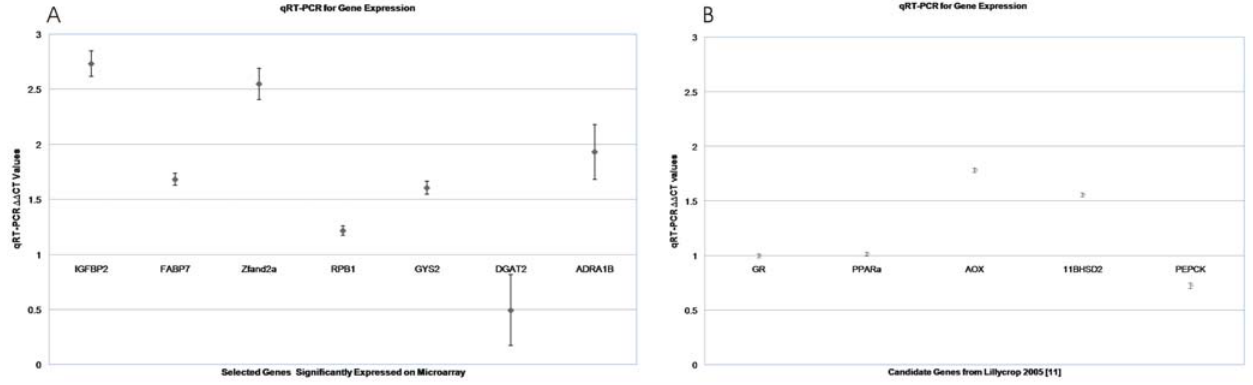
Figure 1. qRT-PCR for Microarray Verification. QRT-PCR for the two treatments was run in triplicate with cyclophilin as a control. The DD CT values are shown for each gene along with error bars for standard error. (A) Seven genes were chosen from the 249 significantly differentially expressed genes on the Illumina microarray. The RNA from the 8 biological replicates was pooled for each of the two treatment groups. In Table 2, the DD CT values have been converted into a fold change for comparison to the array results. (B) Five Previously Published Candidate Genes from Lillycrop et al. [11] were analyzed be qRT-PCR. Each of the eight individual samples was run in triplicate (24 data points for each treatment group). Due to the large number of data points, the error bars are very small and difficult to see.